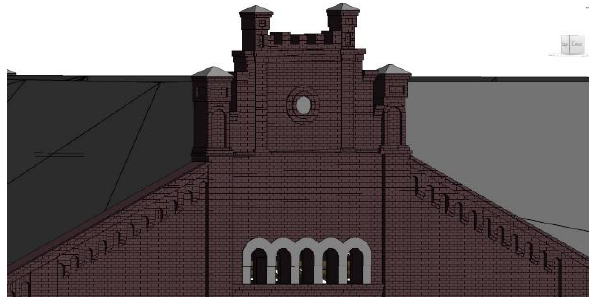
Figure 5. Section of front facade with decorative fixtures